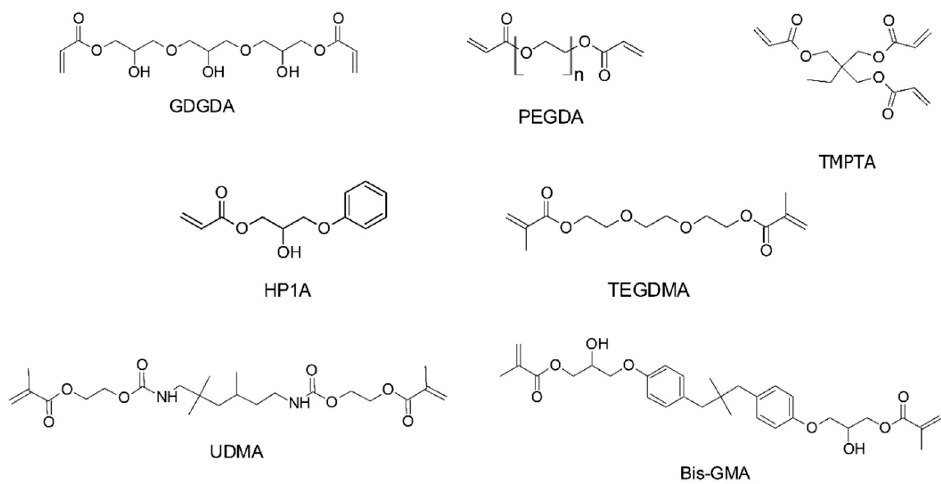
Figure 18. Structures of selected acrylates and methacrylate monomers typically used for vat photopolymerization-based 3D printing.